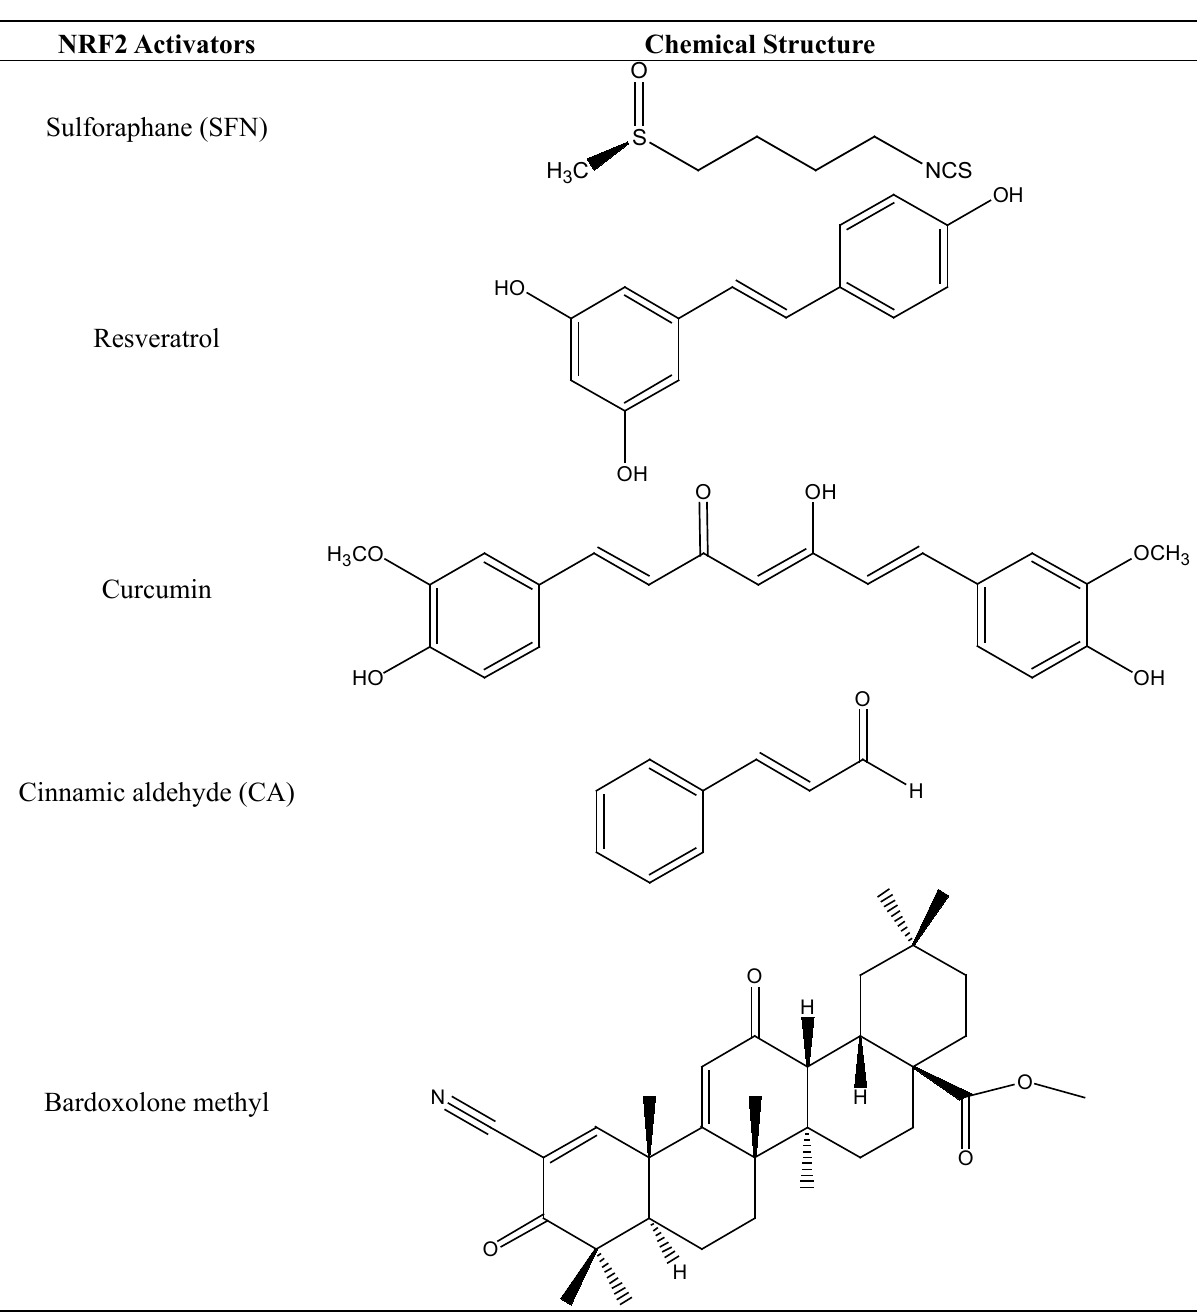
Table 3. Chemical structures of NRF2